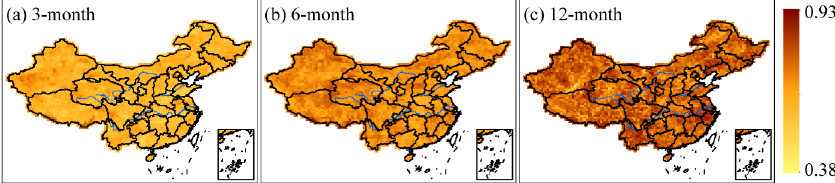
Figure 6. The spatial distribution of the Kendall correlation coefficients between the drought dura- tion and severity at different time scales: ( a ) 3-month, ( b ) 6-month, and ( c ) 12-month. and severity at different time scales: ( a ) 3-month, ( b ) 6-month, and ( c )